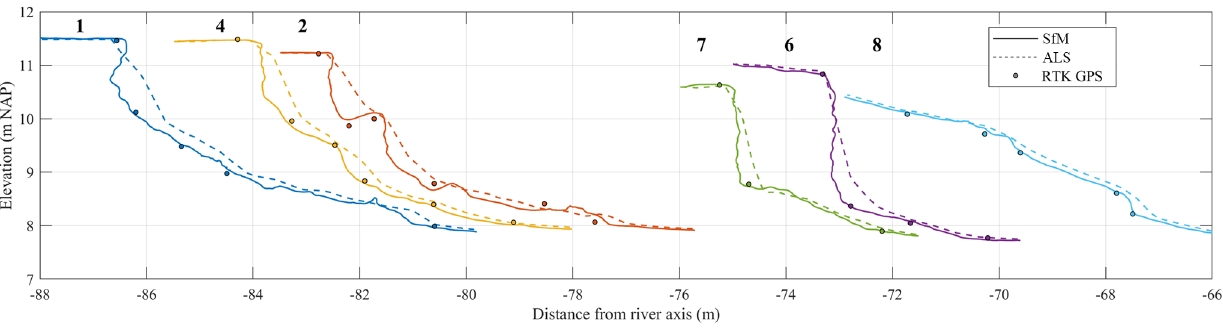
imity to the GPS points than the ALS in almost all